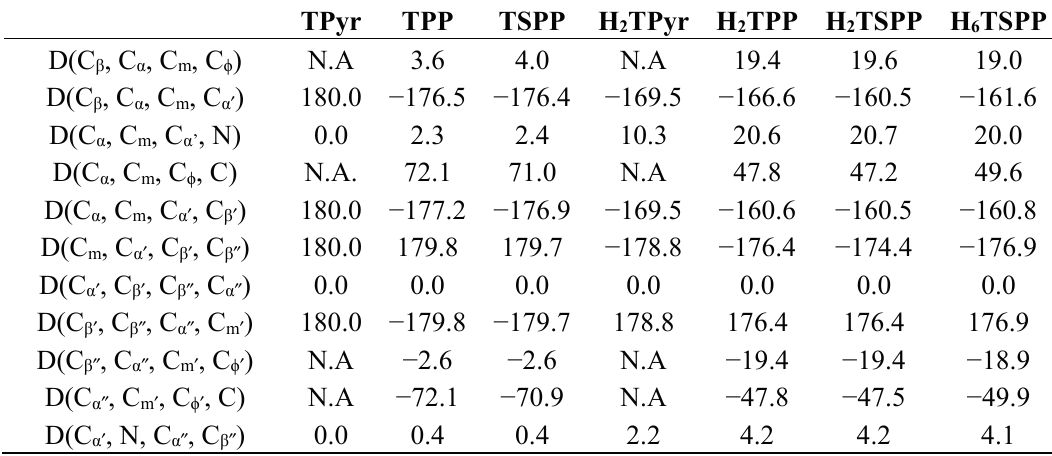
Table 1. Selected dihedral angles (D) and bond angles (A) of free-base porphyrin (TPyr), meso -tetraphenylporphyrin (TPP), and the anionic meso-tetrakis( p -sulfonatophenyl)porphyrin (TSPP) as well as their protonated structures (H 2 TPyr, H 2 TPP, H 2 TSPP and H 6 TSPP). The calculations were done in water at the B3LYP/6-311G(d,p) level of the DFT. TPyr